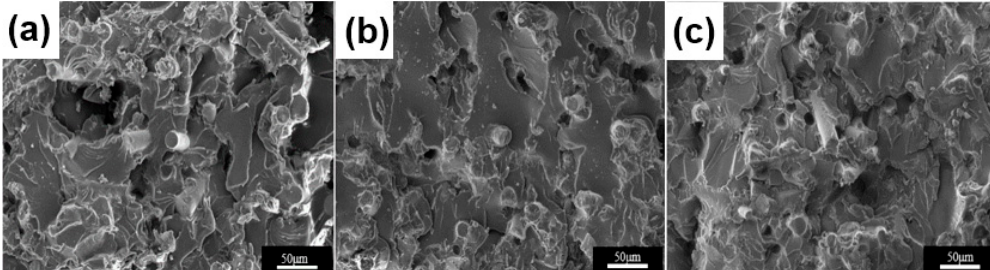
Figure 8. SEM micrographs of the cross section of composite material with a glass fiber content of ( a ) 80 vol.%, ( b ) 70 vol.%, and ( c ) 60 vol.%.